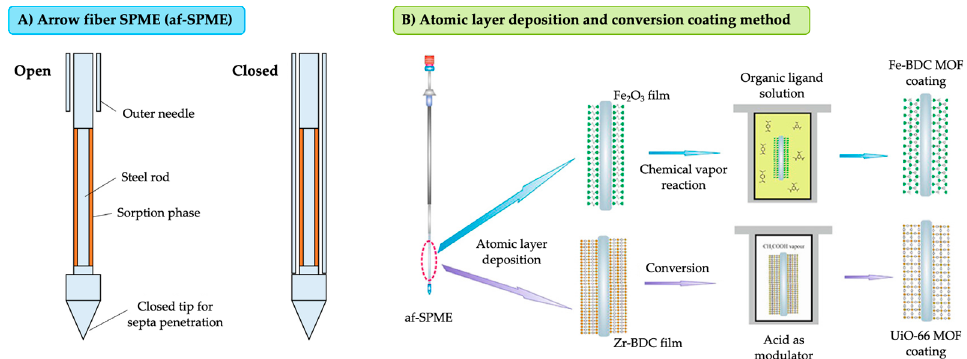
Figure 5. ( A ) Scheme of the af-SPME configuration. Adapted from [43], with permission from Elsevier, 2015. ( B ) Atomic layer deposition and conversion method proposed for the preparation of MOF-based af-SPME devices. Adapted from [71], with permission from Elsevier, 2018.